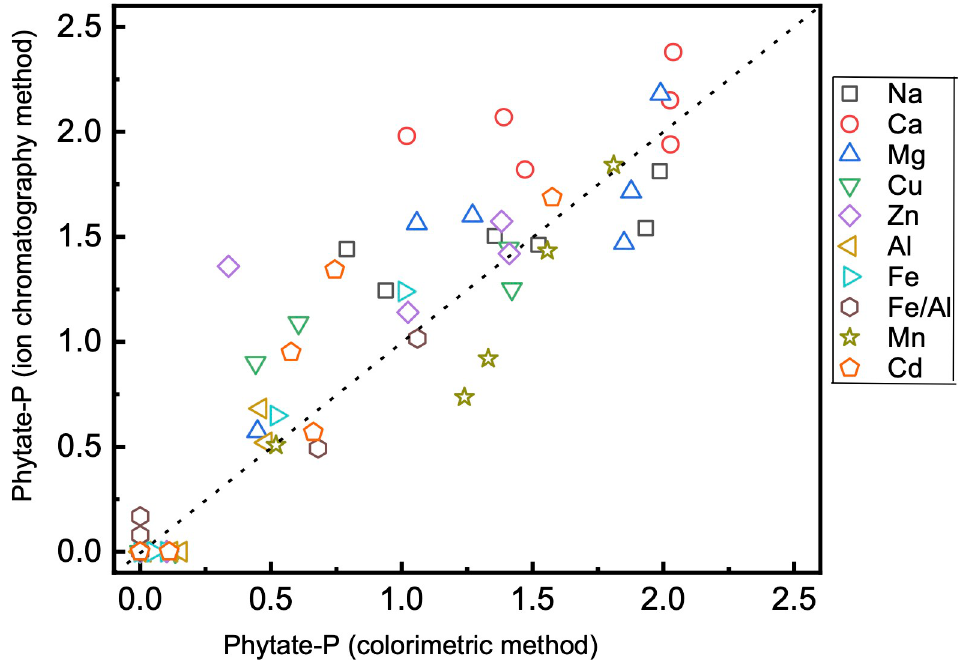
Fig 3. Comparison of dissolved phytate-P concentration at 30 d (in mM) from colorimetric and ion chromatography methods. For the colorimetric method, phytate-P was calculated as the difference between total soluble and inorganic